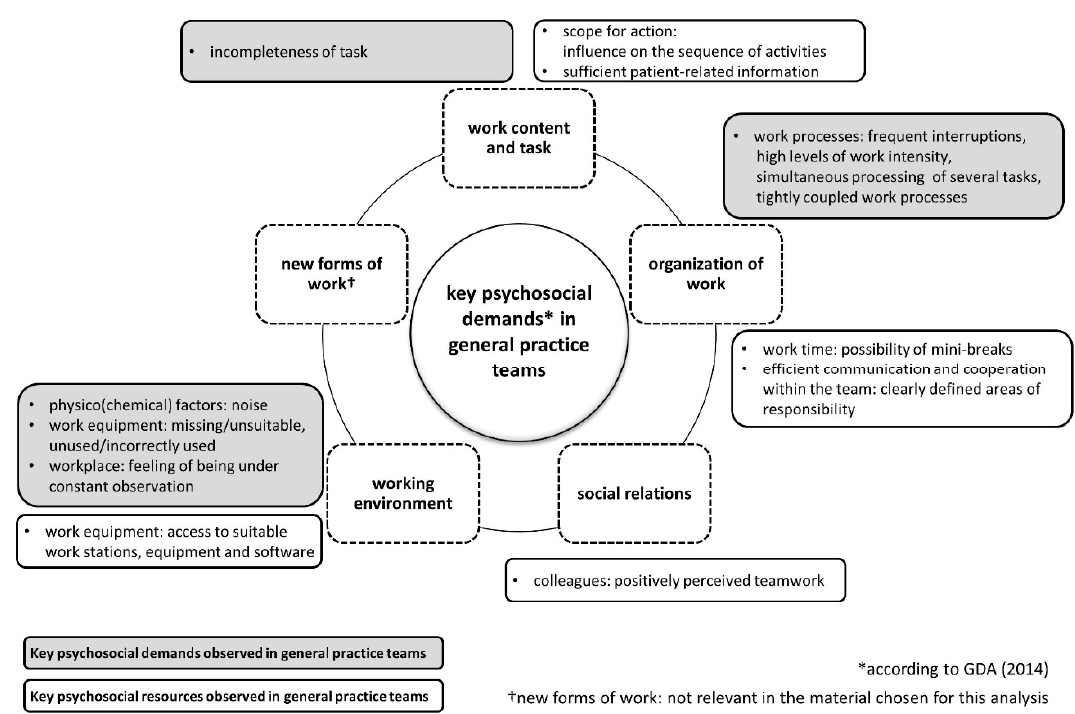
Figure 1. Work-related psychosocial demands, risks, and resources in general practice teams.